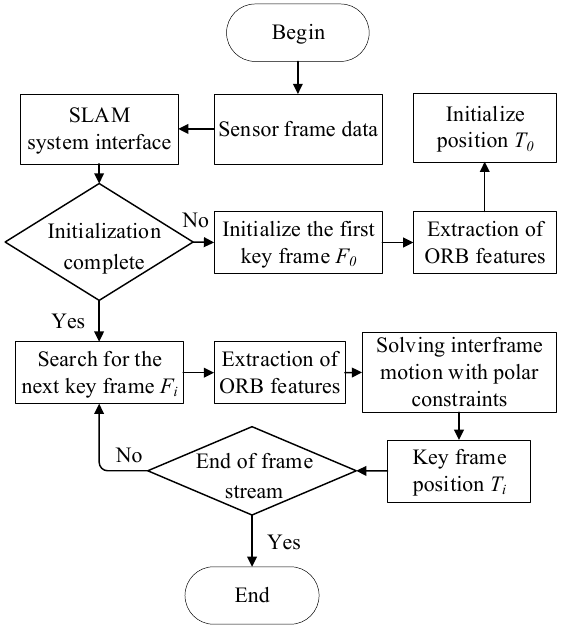
Figure 10. Flowchart of the front end of visual SLAM.